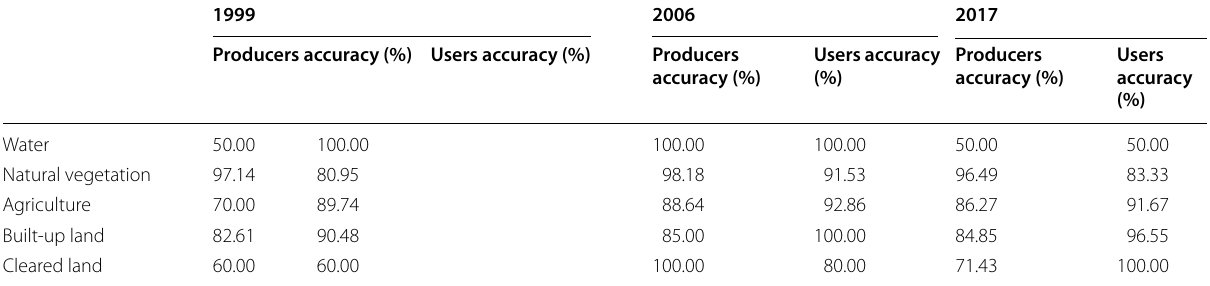
Table 2 The producer’s accuracy and user’s accuracy for the land cover classification maps of 1999, 2006 and 2017, showing the accuracy of the land cover